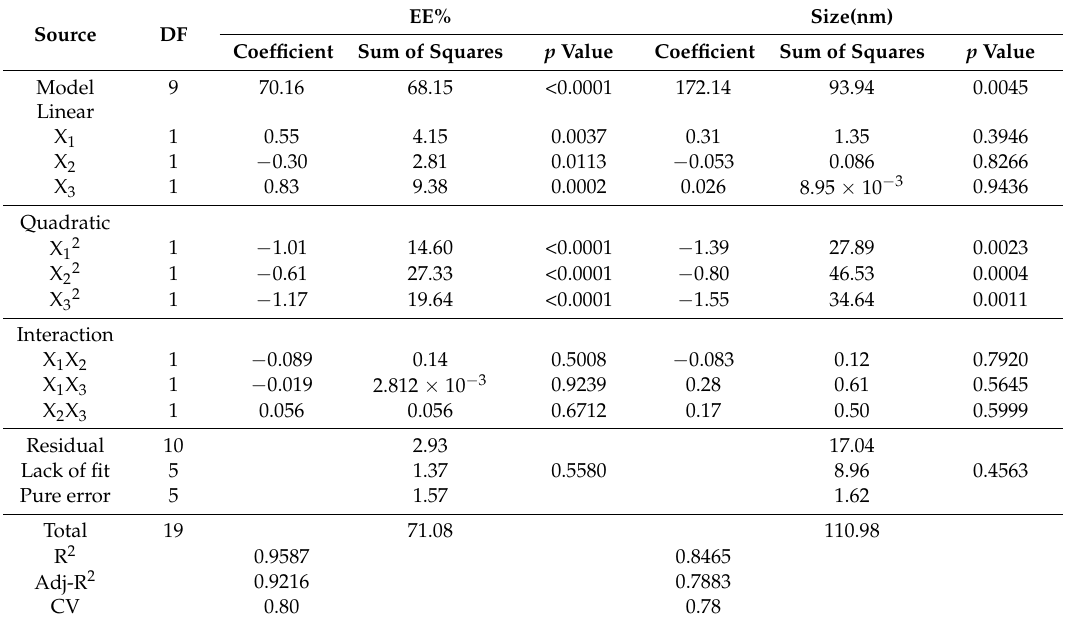
Table 2. ANOVA and regression coefficients of the second-order polynomial model for the response variables (actual